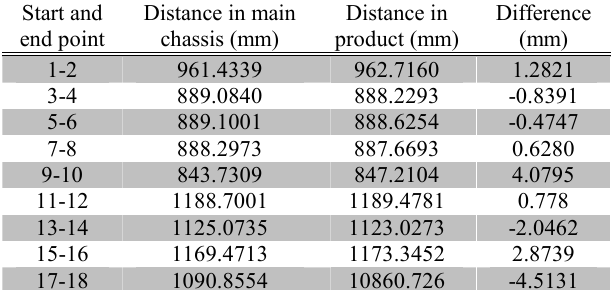
Table 7. Final results for critical points on both chassis